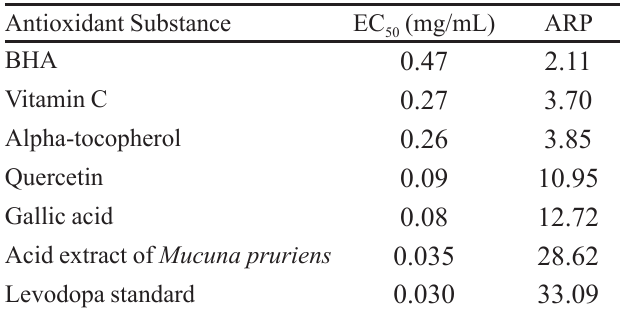
values and anti-radical power (ARP) of TABLE I - EC 50